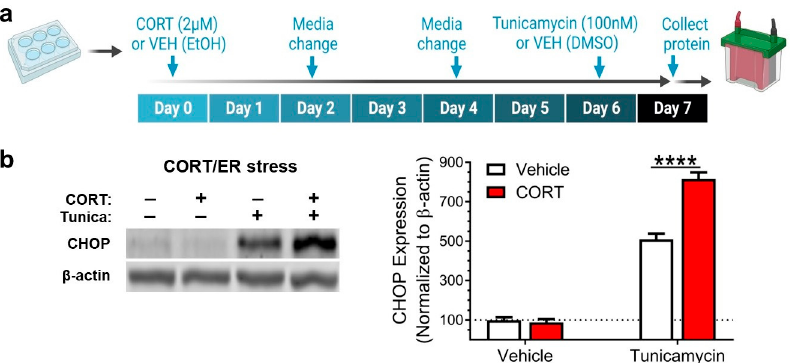
Figure 1. Corticosterone exposure for 7 days makes mHypoE-44 cells more vulnerable to endoplasmic reticulum stress. ( a ) Experimental design: cells were exposed to corticosterone (CORT) or vehicle (VEH; ethanol, EtOH) for 7 days, and tunicamycin was added for the last 21 h prior to protein harvest. ( b ) Pre-exposure to CORT increased the endoplasmic reticulum (ER) stress response induced by tunicamycin, measured as (C/EBP Homologous Protein) CHOP protein levels (two-way ANOVA: interaction: F(1,12) = 42.7, p < 0.0001; Tukey’s post-hoc: VEH/tunicamycin vs. CORT/tunicamycin, **** p < 0.0001; n = 4 for all groups). All values shown are mean ± standard error of the